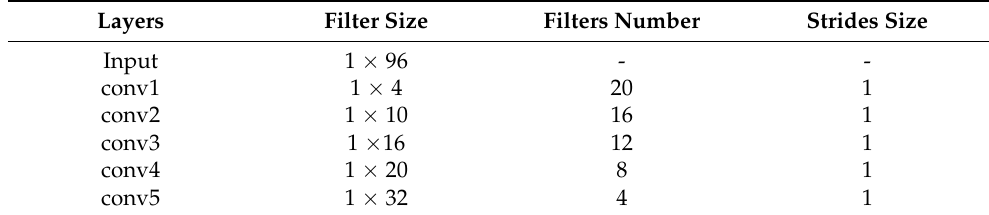
Table 5. CNN-1 configuration of convolution layers.